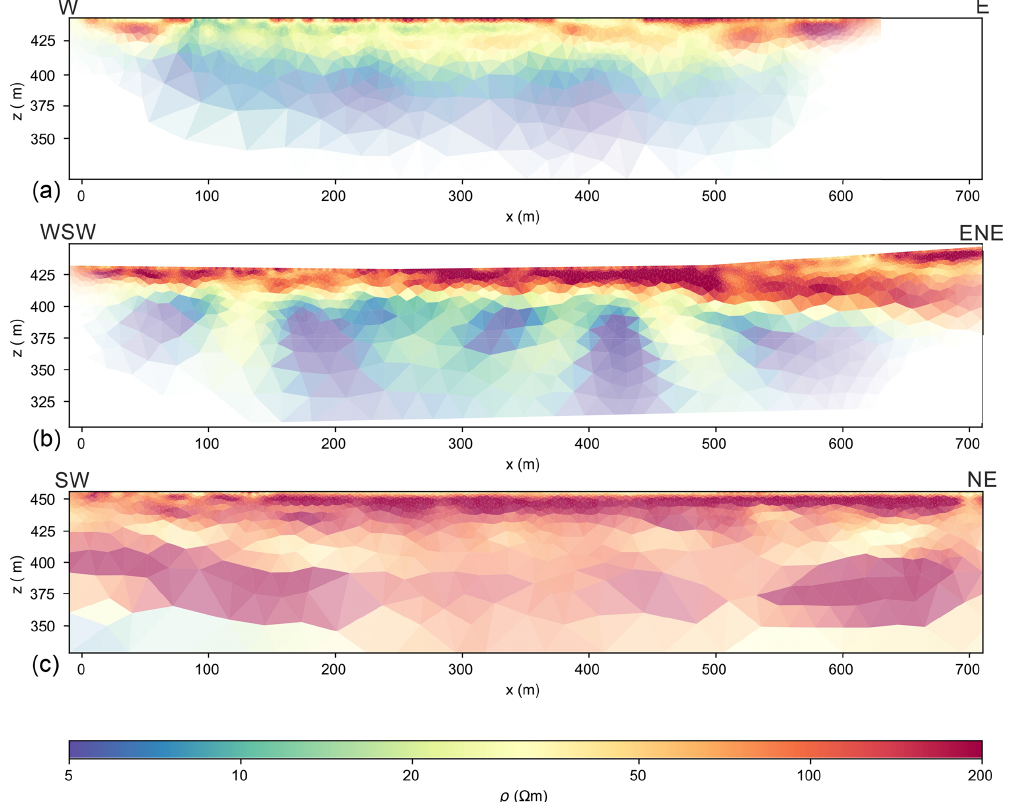
Figure 6. Resistivity distribution of the small-scale ERT profiles: 1 (a) , 2 (b) , and 3 (c) ( z : ma.s.l.; see Figs. 1 and 2 for locations and lithology). Transparency represents the coverage (cumulative sensitivity) and helps avoid the interpretation of uncertain model parts. The relative RMS values are 4.7%, 17.4%, and 4.5%,